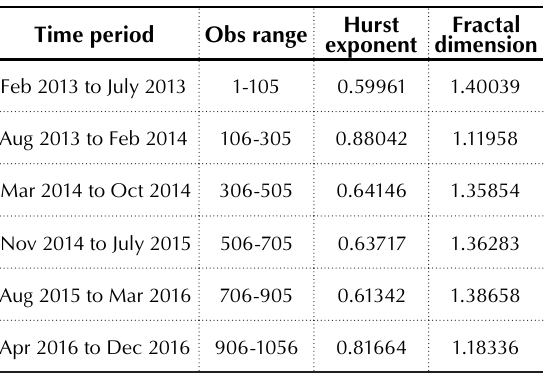
Table 1. Report of Hurst exponent in ReHFT